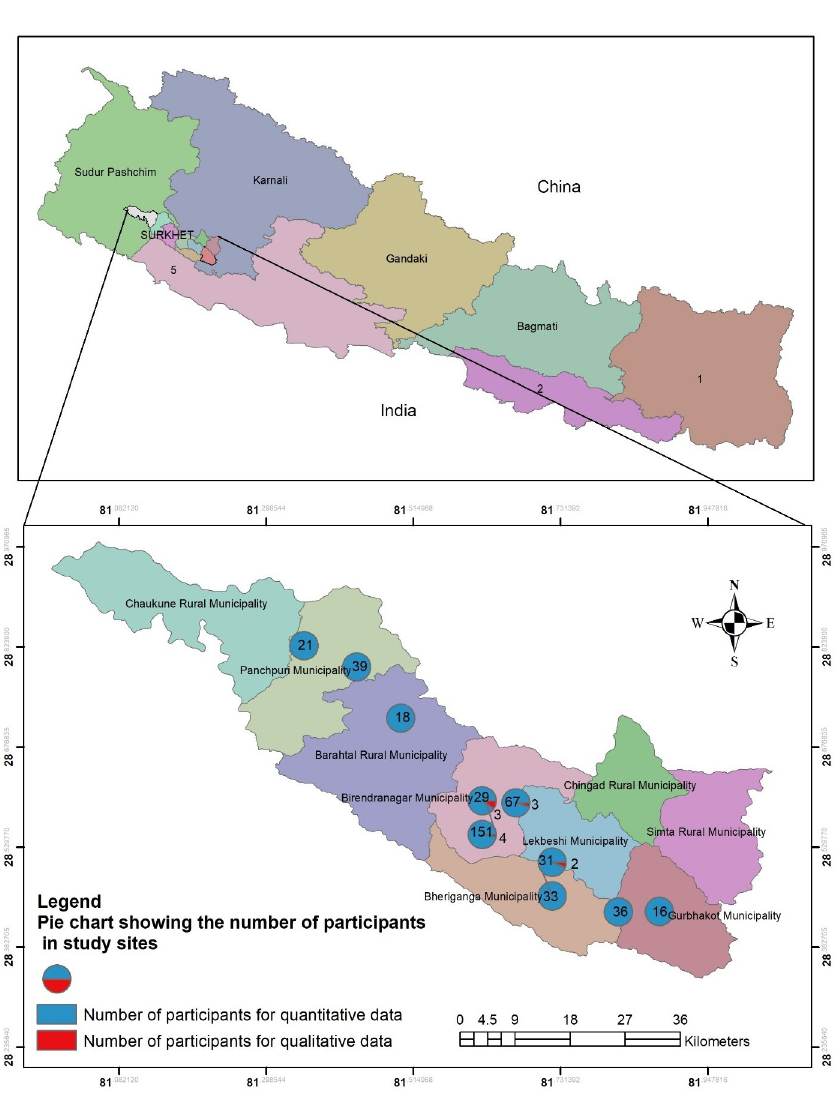
Fig 1. Study sites with number of participants in Surkhet district, Karnali province, Nepal. The map was created was exclusively made for this study with ArcMap version 10.8.1 and GPS coordinates were taken from field